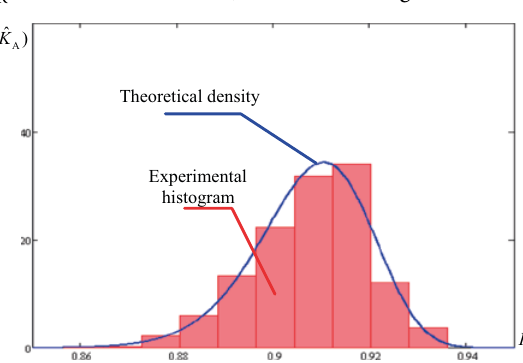
Fig. 5. PDF and histogram of the ready-to-operate factor estimation for the case of exponential distribution of the mean operating time between failures and a stable recovery time